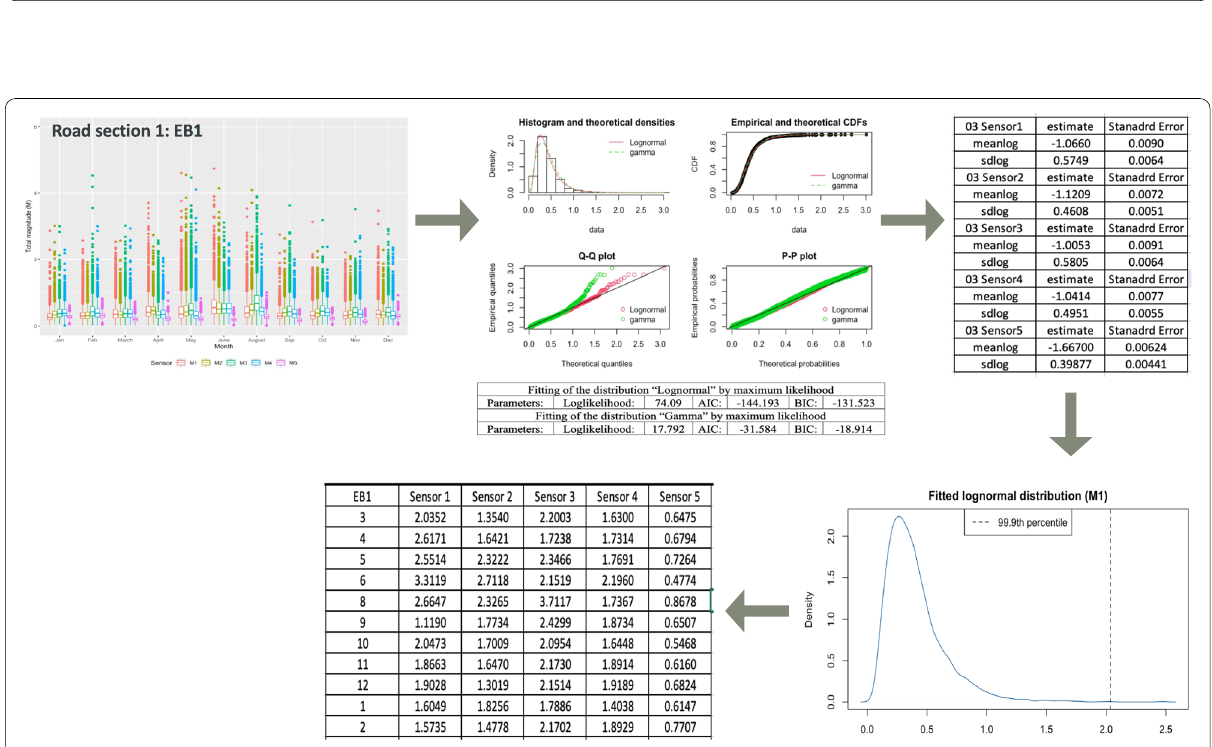
Fig. 4 The process of obtaining threshold values from pavement condition